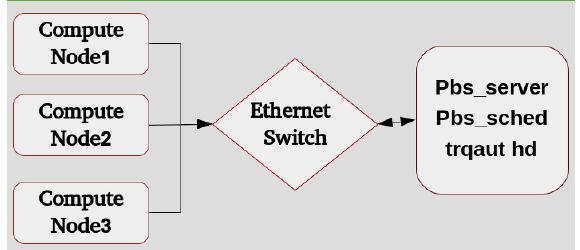
Figure 1. DeepStack cluster